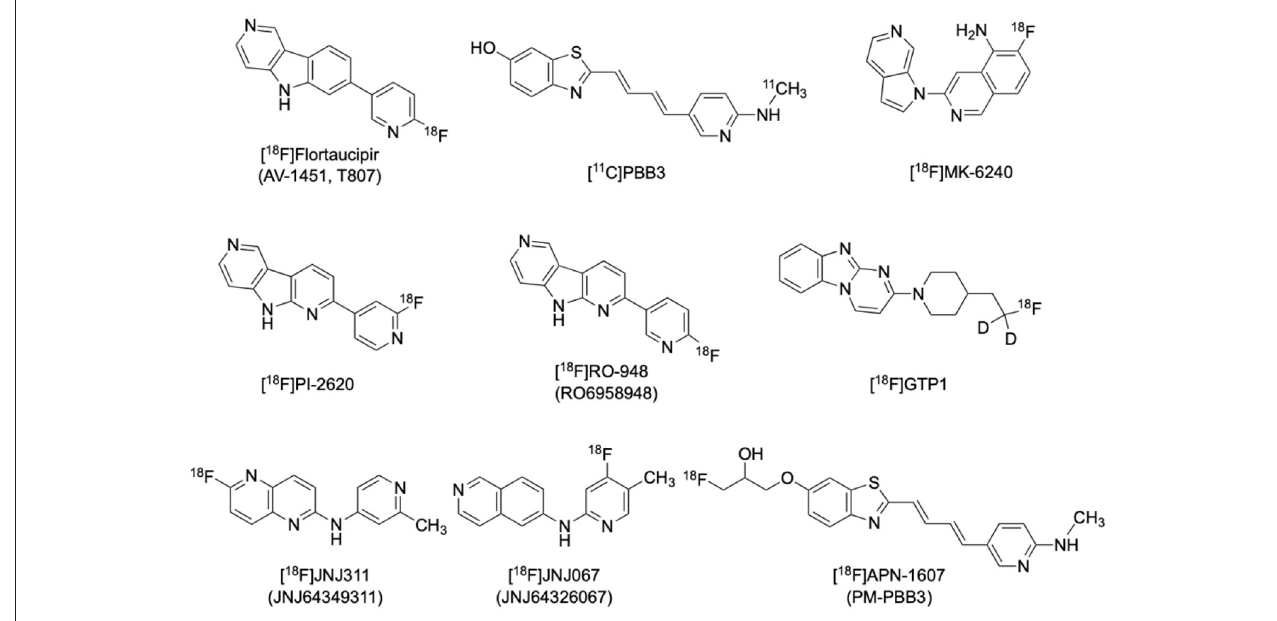
FIGURE 2 | Structures of representative PET radiotracers for tau imaging.